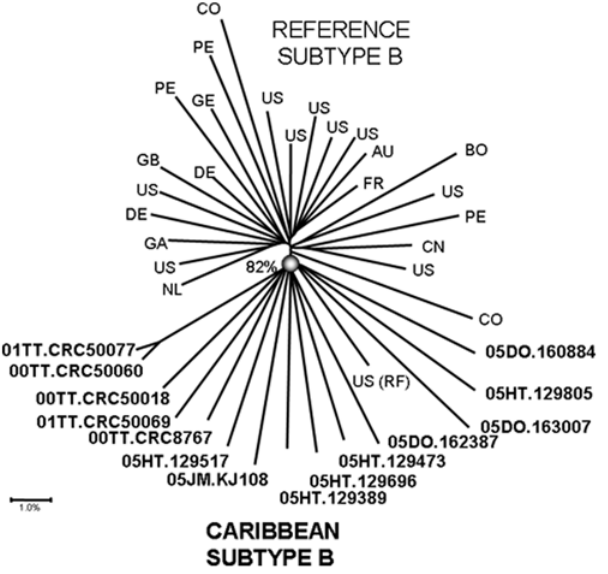
Figure 2. Phylogenetic analysis of 14 nearly full genome sequences of HIV-1 Subtype B from Caribbean countries: Trinidad and Tobago (TT), Dominican Republic (DO), Haiti (HT) and Jamaica (JM). Reference subtype B sequences are indicated by the country of origin; they are: US: MN, JRCSF, SF2, WR27, P896, NY5, BCSG3C, YU2, RF, U23487; DE: D31, HAN; GB: CAM1, study sequences (bold) are identified by name. A neighbor-joining phylogenetic tree was built using the Kimura 2-parameter model and significant parsimony bootstrap values ( . 70%) were placed next to the nodes. The genetic distance corresponding to the lengths of the branches is shown by the scale below the tree.